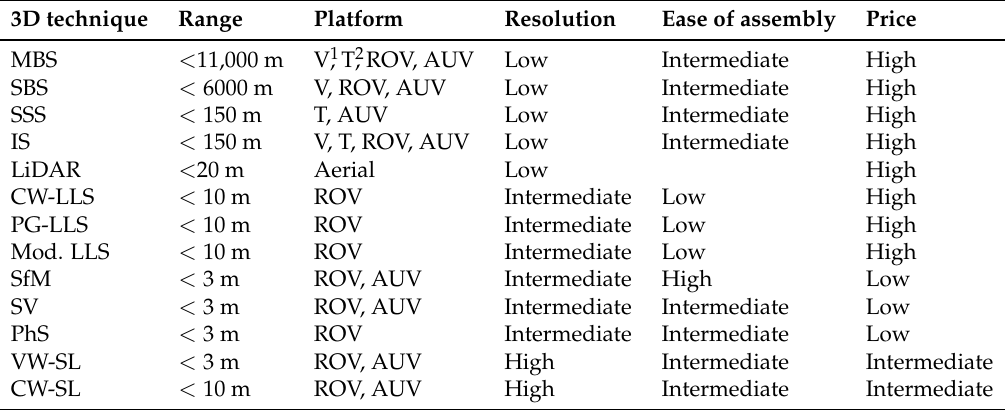
Table 8. Strengths and weaknesses of the sensors and techniques for 3D